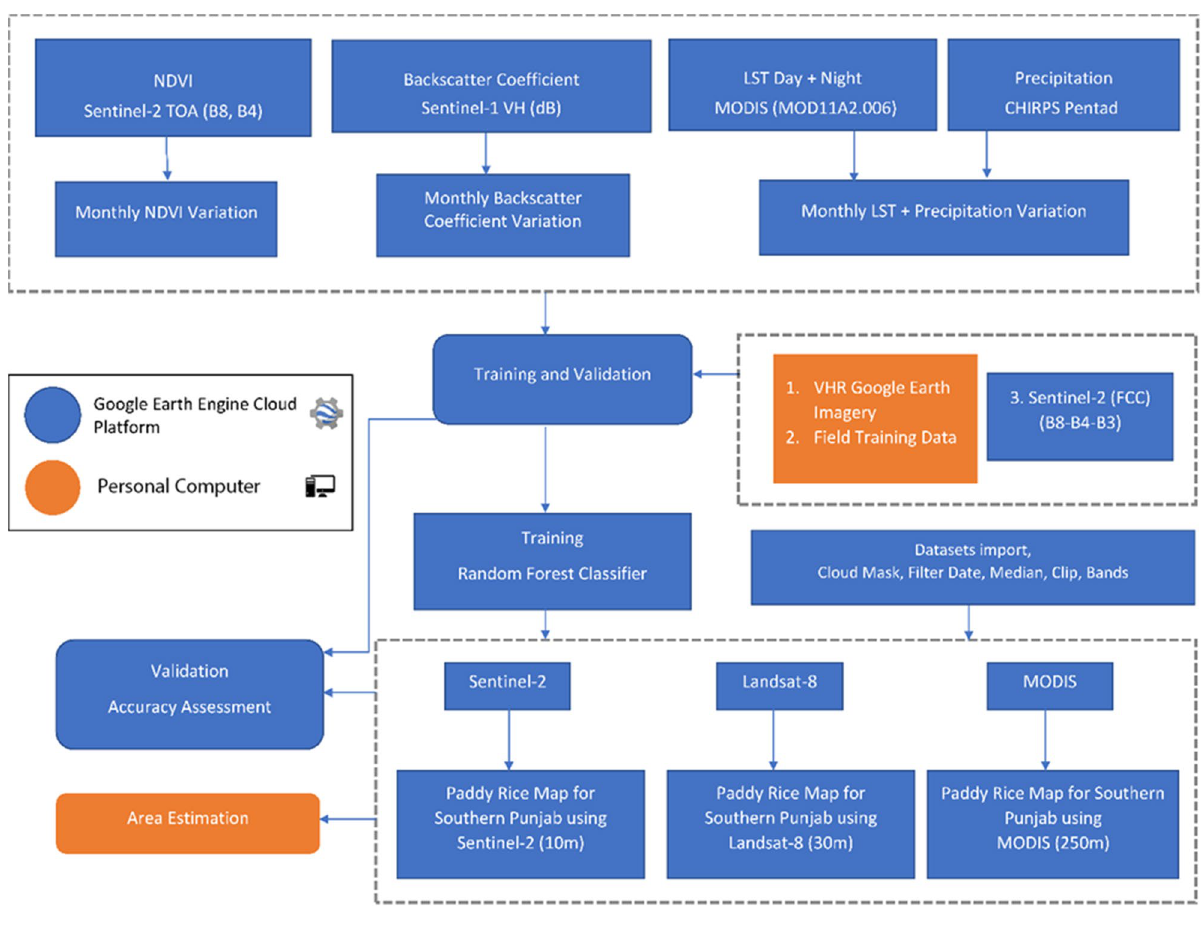
Figure 3. Methodology chart for rice crop classification.